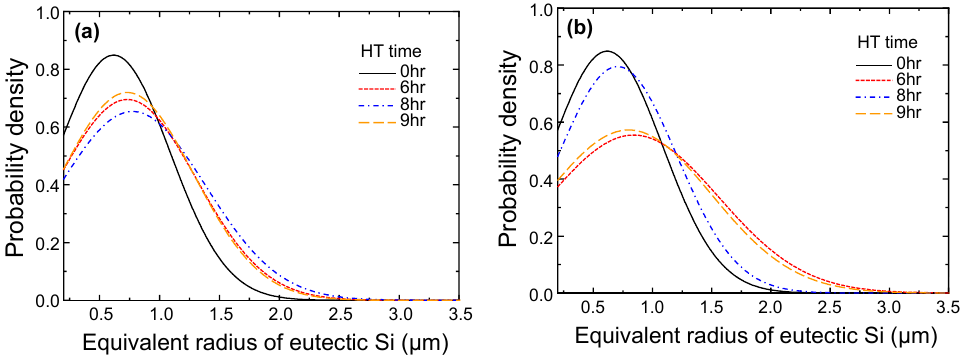
Figure 5. The standard nominal distribution of eutectic Si sizes at different heat treatment tempera- tures: ( a ) 160 ◦ C and ( b ) 200 ◦